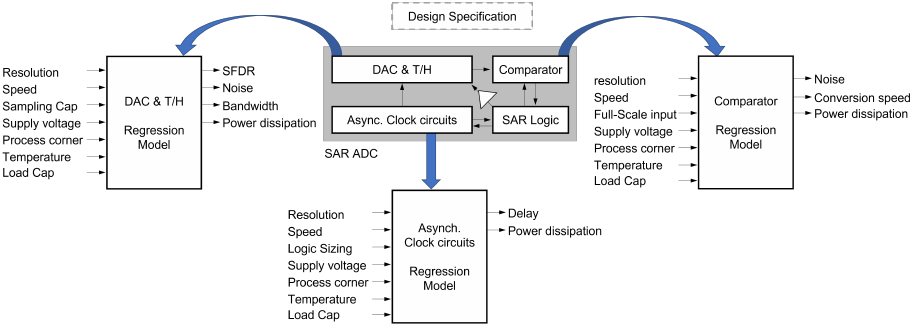
Figure 2. SAR ADC sub-module breakdown and regression